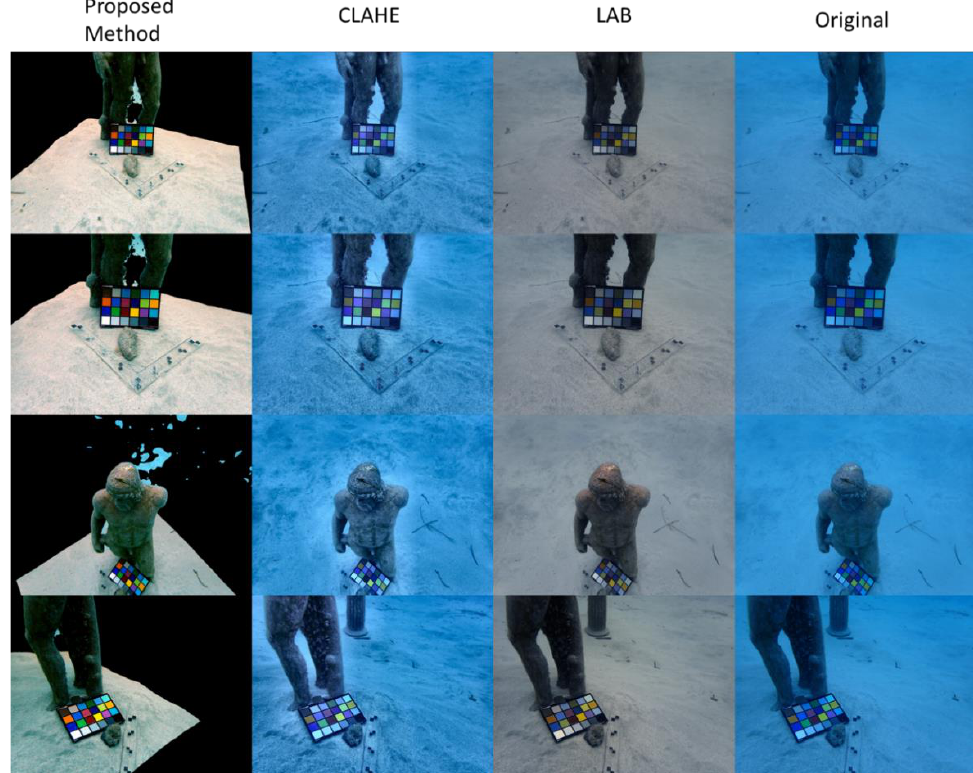
Figure 8: From Left to right the results provided by our algorithm, Lab, CLAHE, and the original images. Images from Protaras dataset